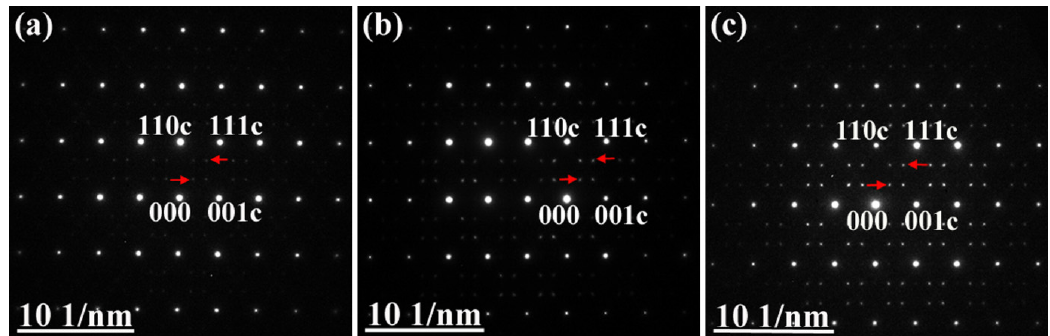
Figure 7. The different intensities of electron diffraction patterns collected along the [110] zone axis for the ordered BZT ceramics: ( a ) the sintered sample without annealing; ( b ) the annealed sample at 1300 ° C for 12 h; ( c ) the annealed sample at 1400 ° C for 12 h.